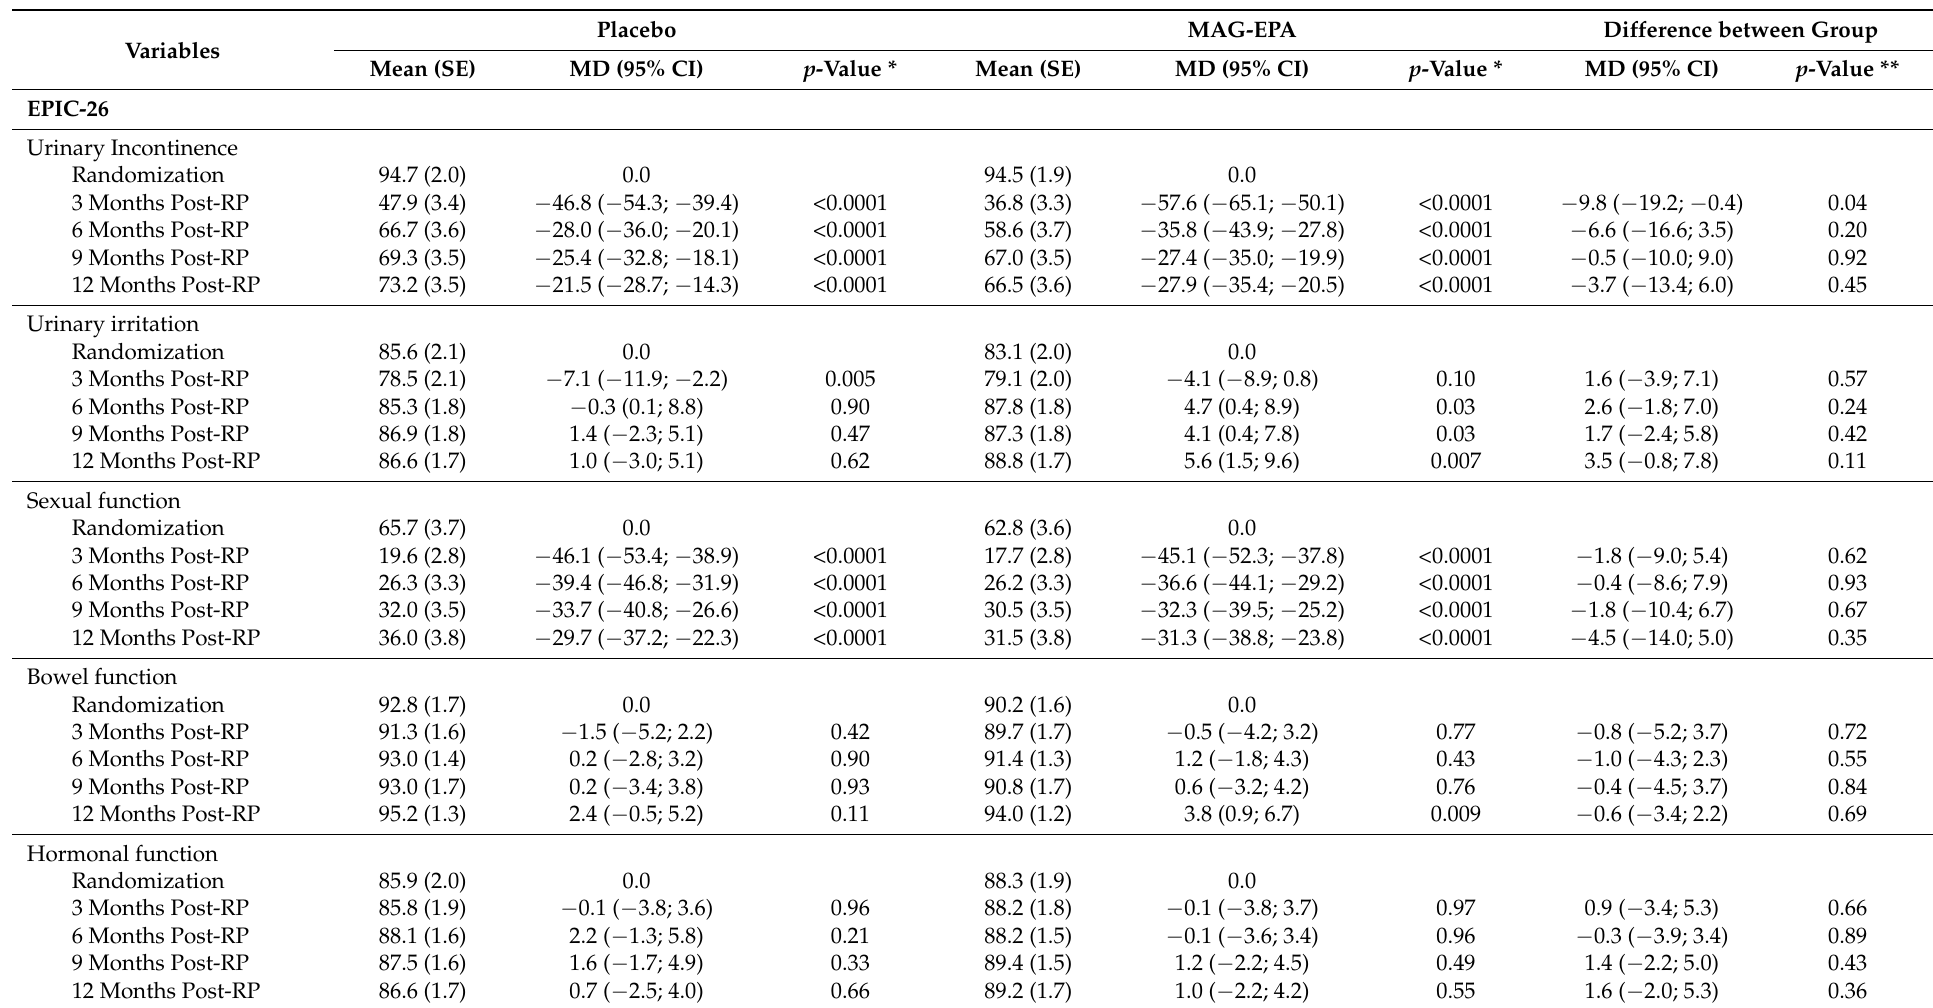
Table 2. Associations between quality-of-life functions and MAG-EPA intervention, intention-to-treat analysis.